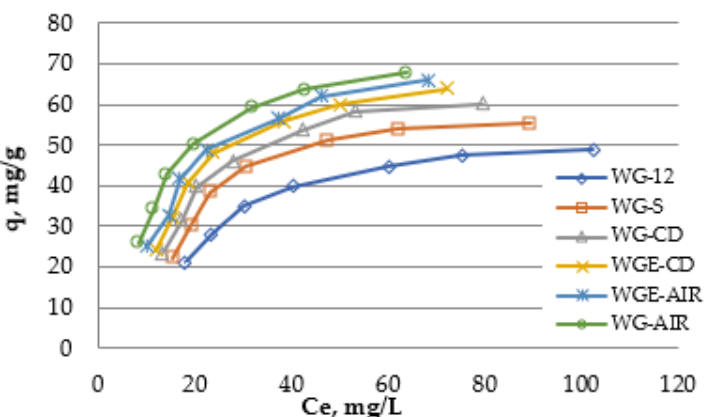
Figure 9. Oxytetracycline adsorption isotherms for the starting activated carbon WG-12 and sorbents resulting from the modification. Table 11. Oxytetracycline adsorption isotherms on modified activated carbons.